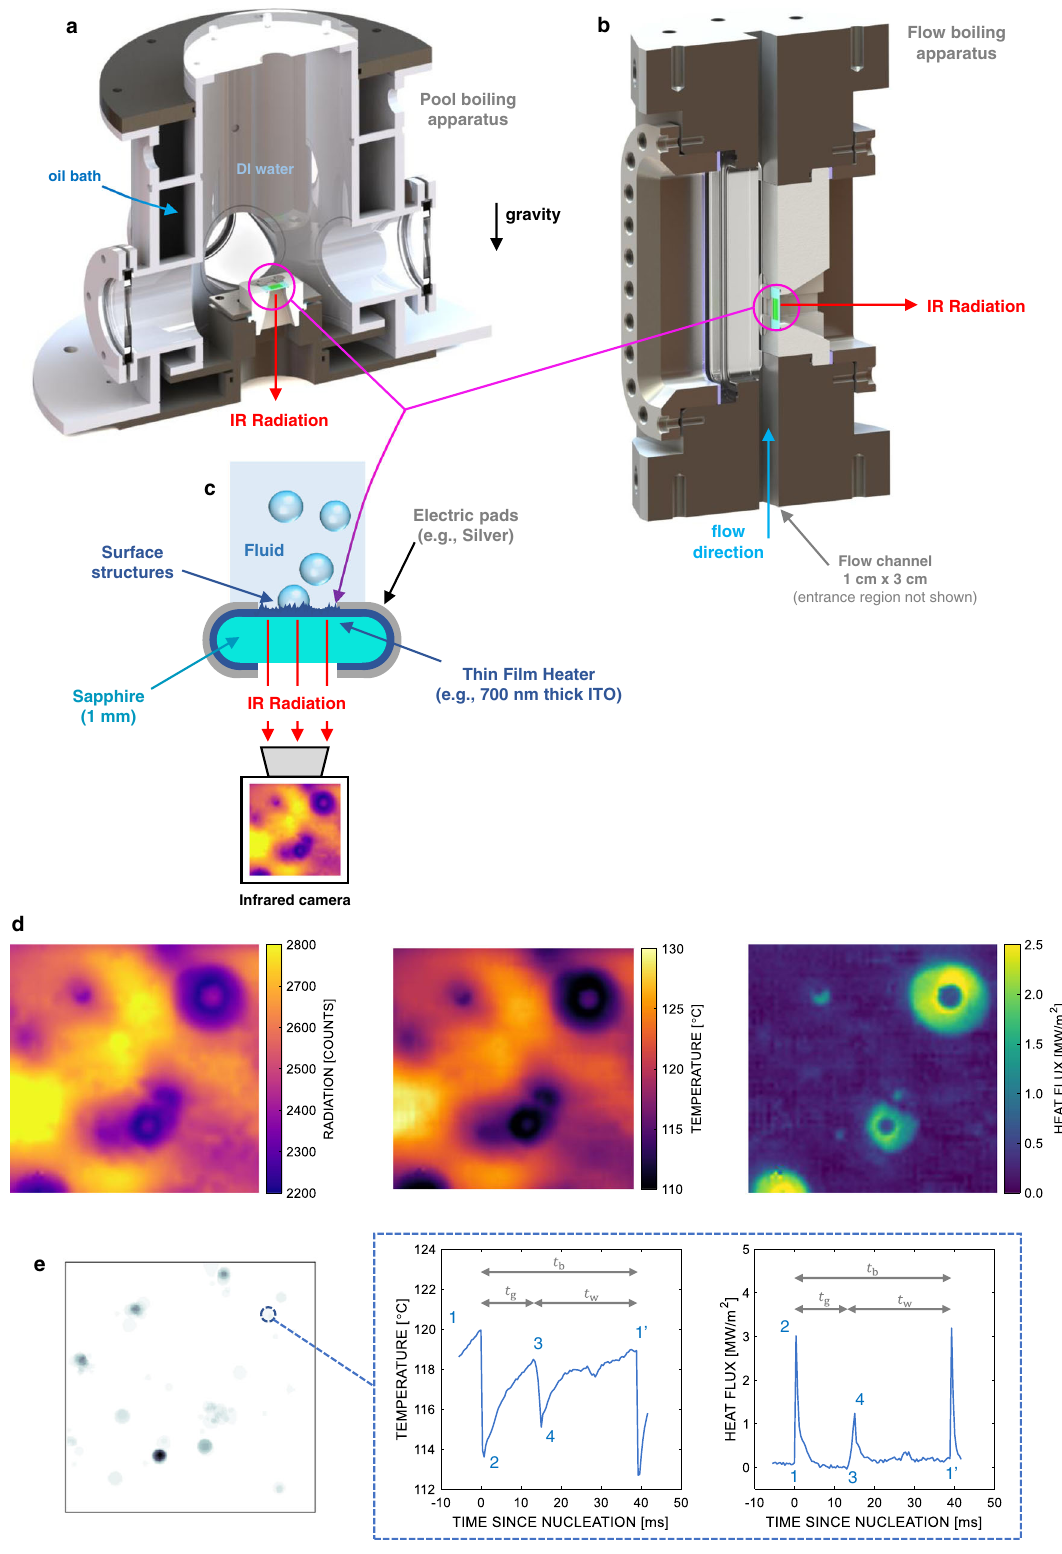
Fig. 4 | Test sections used for water experiments with infrared heaters and sample results. a Cross sectional view of the pool boiling apparatus used for boilingexperimentswithwater. b Crosssectionalviewofthe fl owboilingapparatus used for boiling experiments with water. c Sketch of the infrared heater (not to scale). d Examples of instantaneous infrared radiation distribution (left) and the